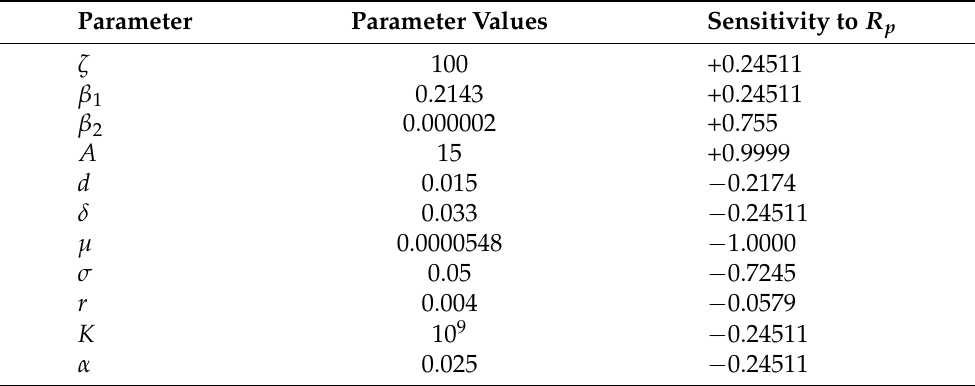
Table 3. Table showing numerical values of sensitivity indices for the cholera